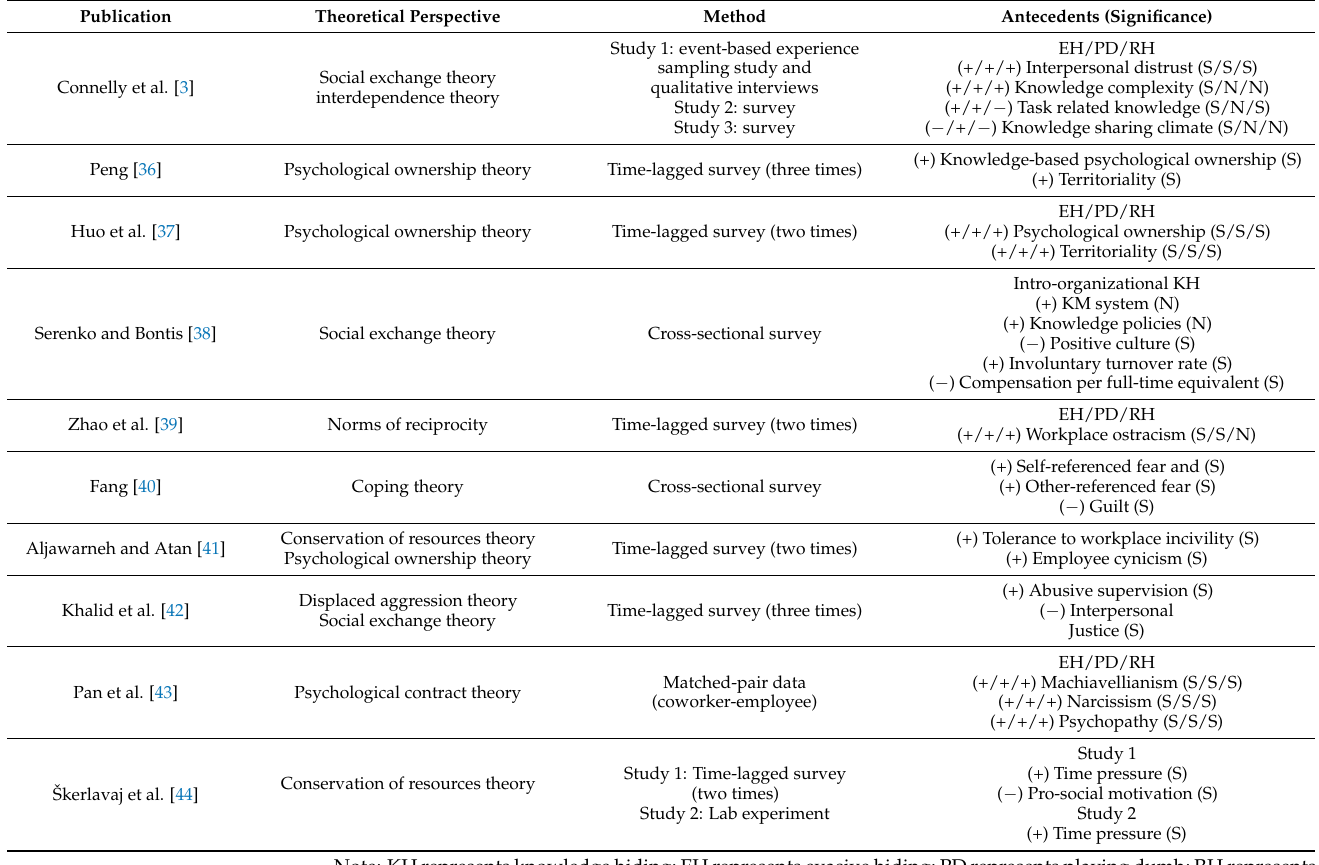
Table 4. An example of the summarizing of empirical knowledge-hiding studies.